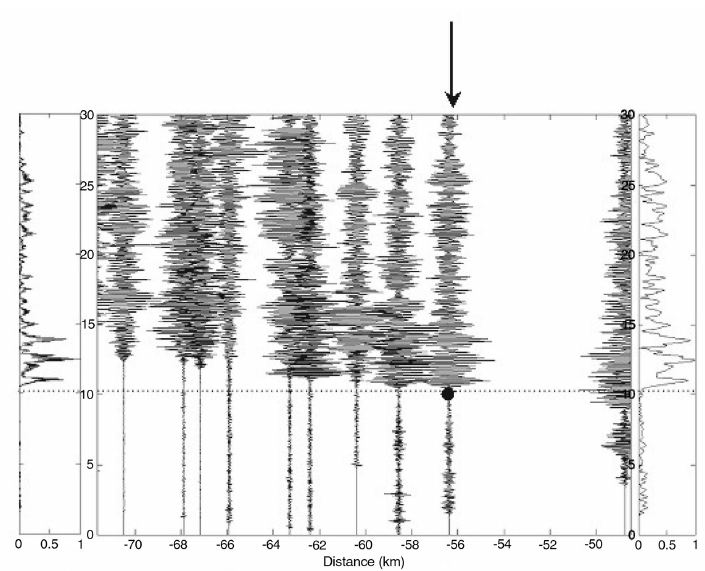
Fig. 2. An example of the picking procedure applied to the seismic trace indicated by the arrow: the CF func- tion and the modulus of the Hilbert Transform (see text for details) calculated for the selected seismic trace are shown on the left and on the right of the seismic section respectively; the dot indicates the travel time picked on the signal. Independently the picking is also carried out on the CF function and Hilbert Transform and the first- arrival time is calculated as the mean value of the three